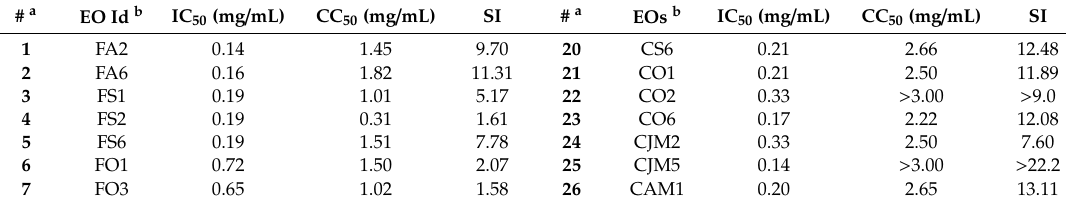
Table 2. Essential oils’ (EOs’) anti-HSV-1 (IC 50 ), cytotoxicity (CC 50 ) and selectivity index (SI) of the tested